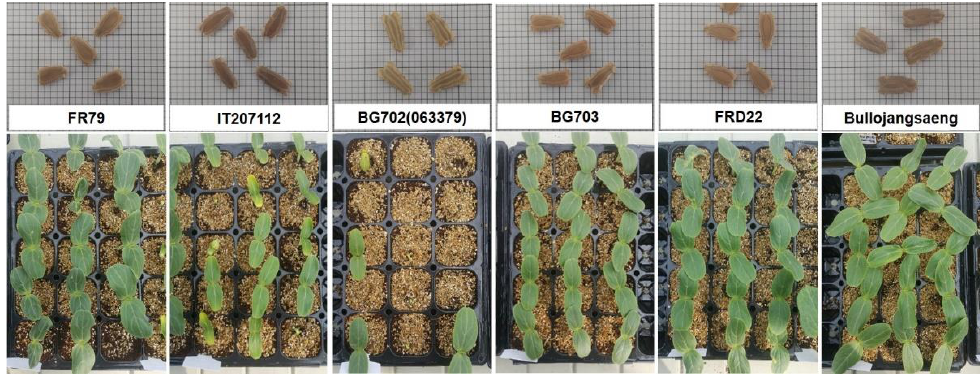
Figure 3. Germination percentage of Lagenaria rootstock accessions after sowing ( A ) and at seven days after sowing ( B ).